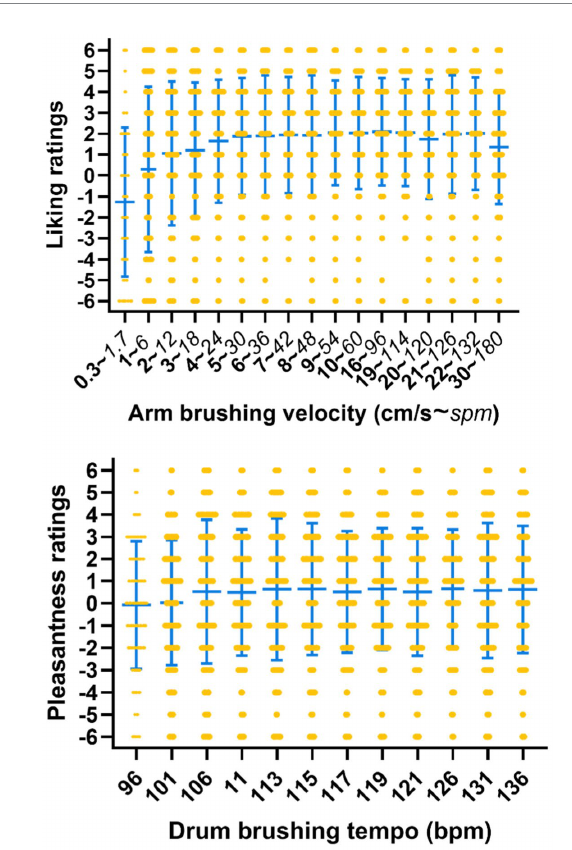
FIGURE 9 Liking ratings for different arm brushing velocities (upper) in cm/s or right above in strokes per minute: spm, one dot per participant. Pleasantness ratings (lower) for different drum brushing tempos, one dot per participant. Higher values indicate higher liking and higher pleasantness. Blue bars indicate mean and standard deviation across participants.